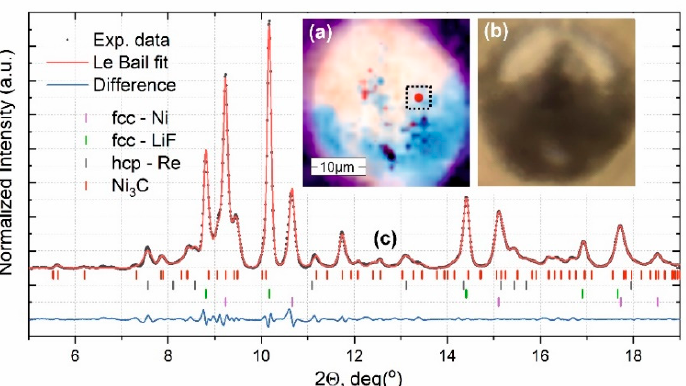
Figure 2. ( a ) Two-dimensional X-Ray diffraction mapping of the sample chamber. The color map allowing to distinguish between the present phases. The intensity of the colors is proportional to the intensity of particular reflections: the dark purple region beyond the pressure chamber corresponds to the (100) and (101) reflections of the Re gasket; the blue region—the (200) reflection of the Ni; The orange region—the (111) reflection of LiF; (020) and (301) reflection of Ni 3 C for the red region. ( b ) A comparison view of the sample chamber under an optical microscope. ( с ) Powder diffraction pattern the temperature quenched sample at 184(5) GPa at the position highlighted by a black dotted square on the XRD color map.